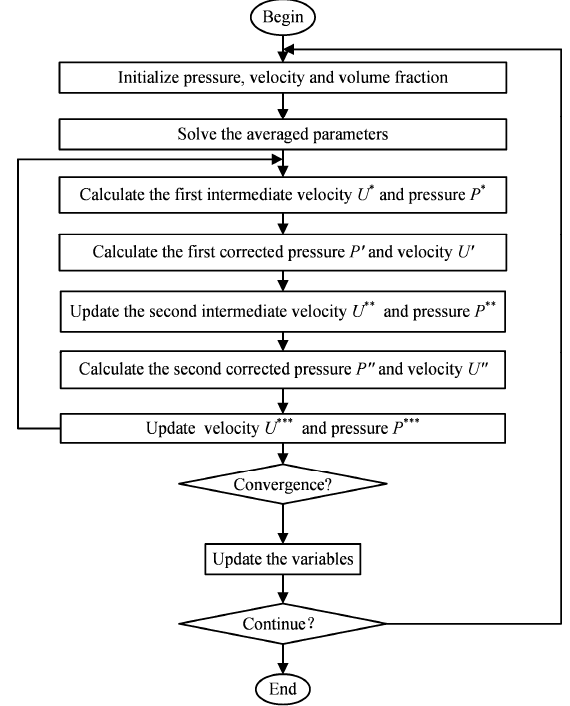
Figure 3. The flowchart of the PISO algorithm.